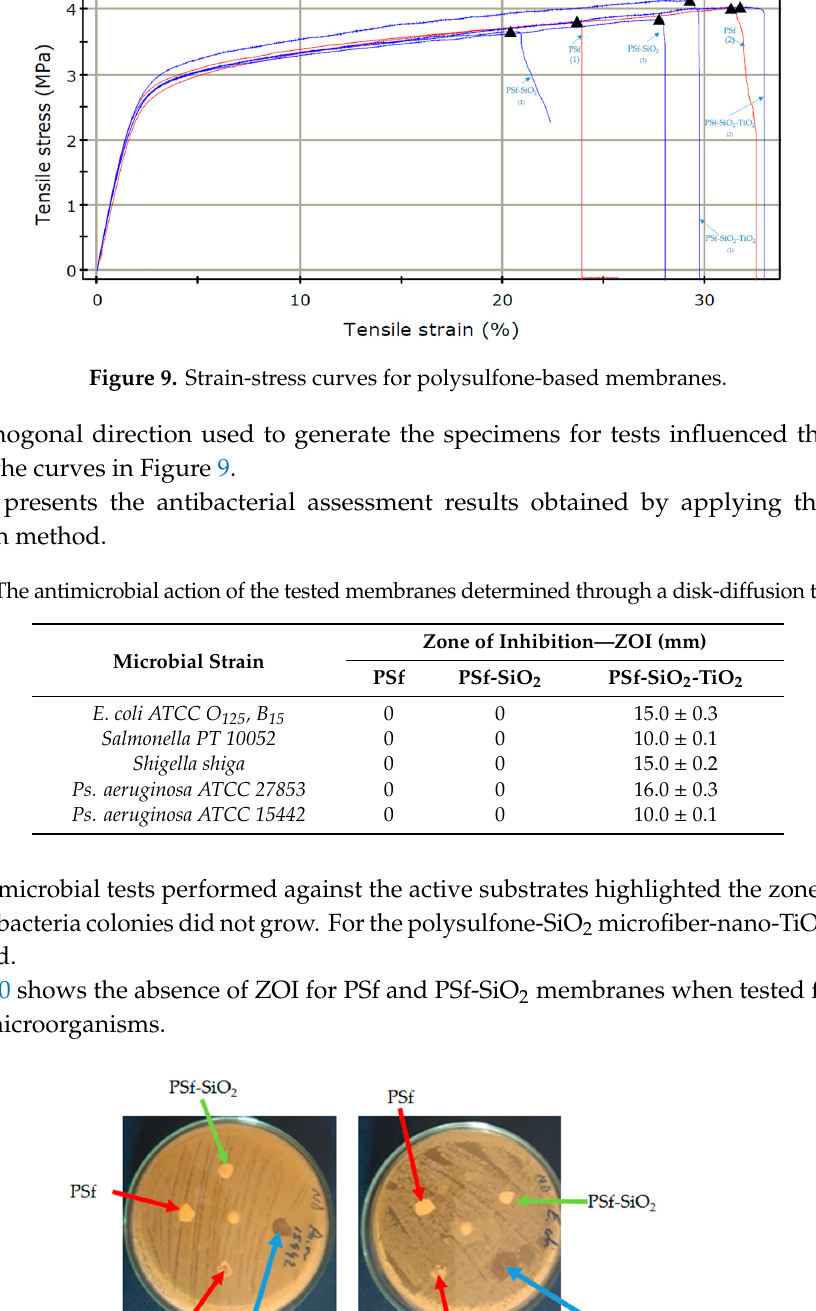
Table 7. Bacteriological analysis results for Candida albicans ATCC 10231 strain. Sample Analyzed Figure 11. Candida albicans proliferation for the tested PSf-SiO 2 membrane. 4. Discussion The intensive use of polysulfones for the preparation of microporous, dense, and composite membranes is justified by the performance of these polymers [42–44], namely: high solubility in polar aprotic solvents and thus great possibilities to obtain membranes by phase inversion; thermal resistance up to approximately 200 °C; chemical resistance over the whole pH range and in oxidative environments; diffusion coefficient of 3.3 × 10 − 11 cm 2 /s at 15 °C; mechanical resistance; and selectivity for gas mixtures. Performance enhancement and widening of polysulfone membrane applications have been amplified by including silica for obtaining micro- or nano-metric silica composites, but their synthesis is often costly, complicated, and non-reproducible [26,45–48].